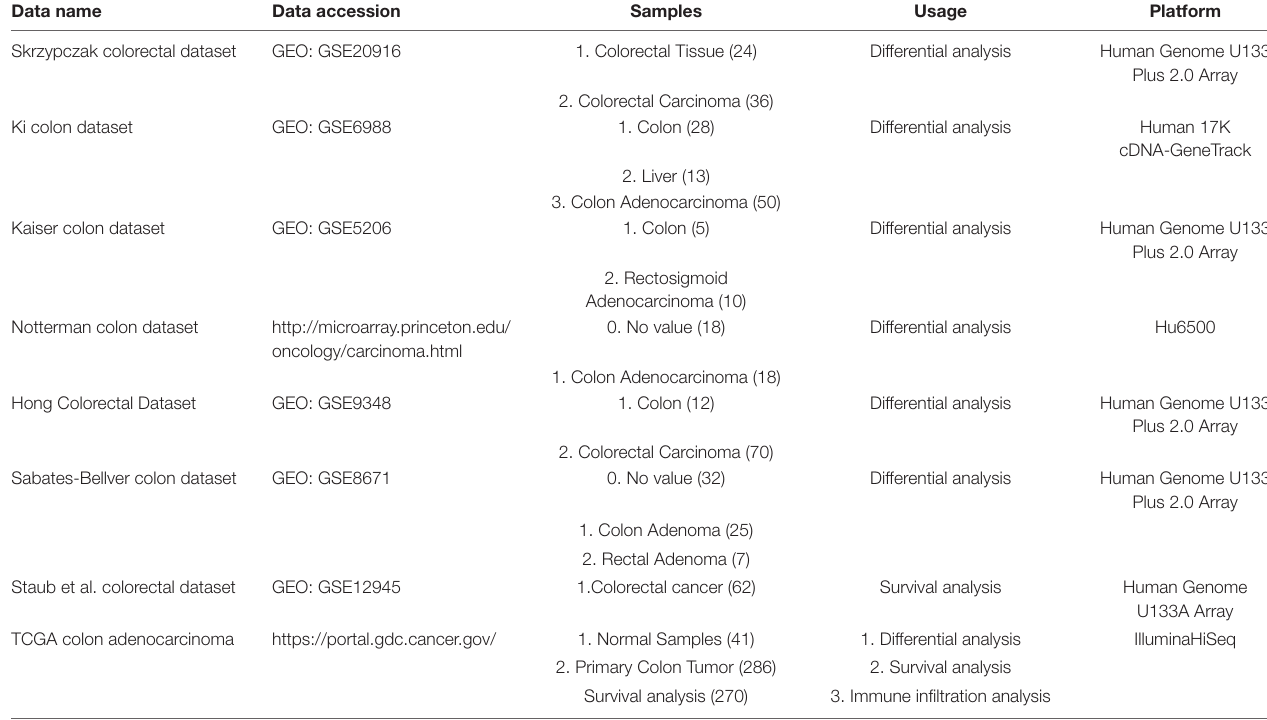
TABLE 1 | The detail information of COAD datasets in our analysis